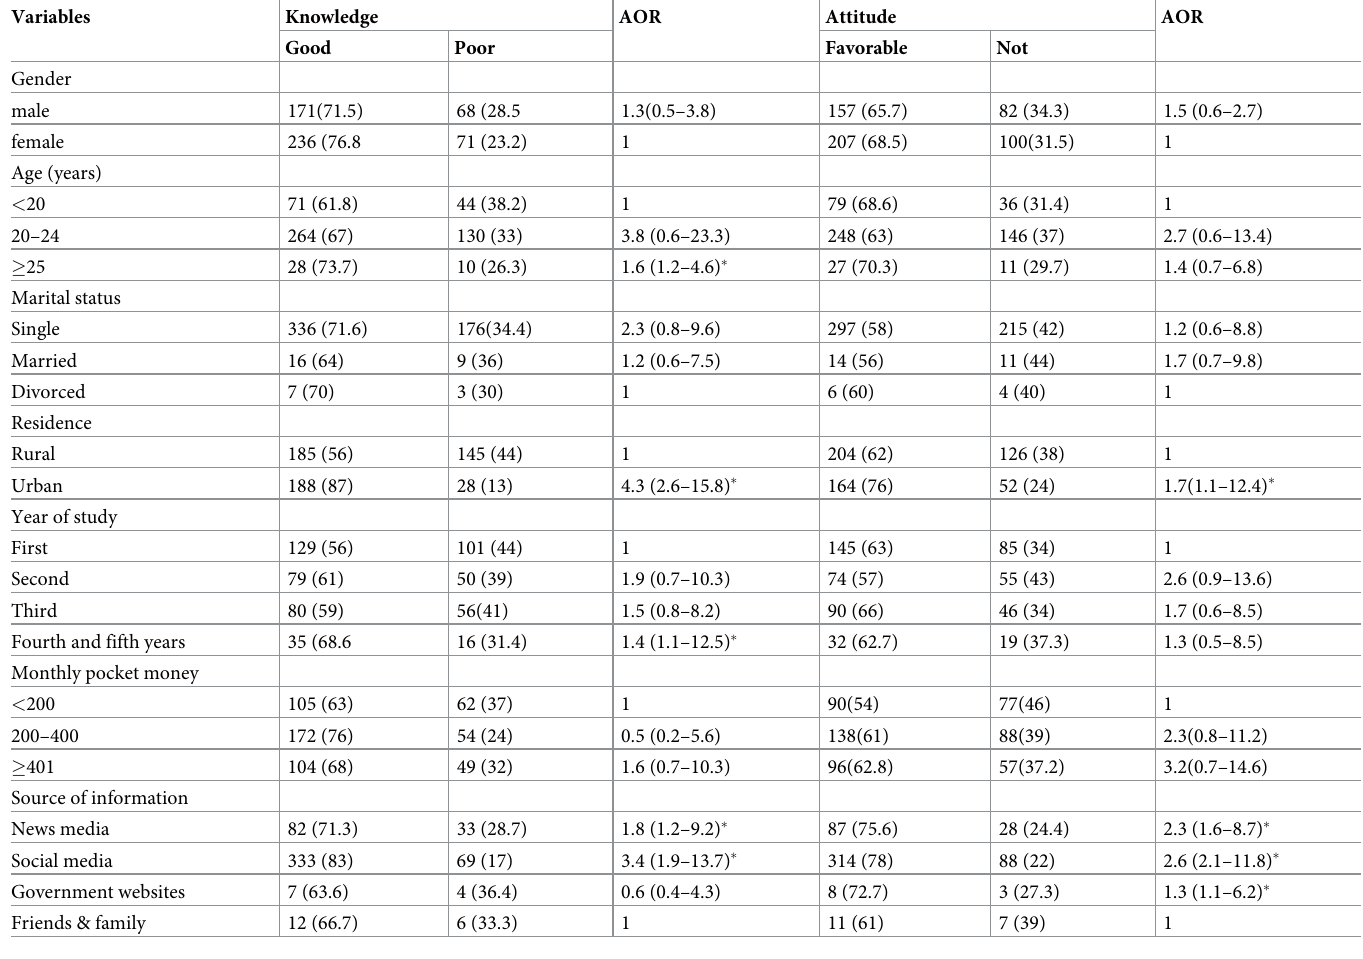
Table 5. Factors associated with knowledge and attitudes towards COVID-19 among students at